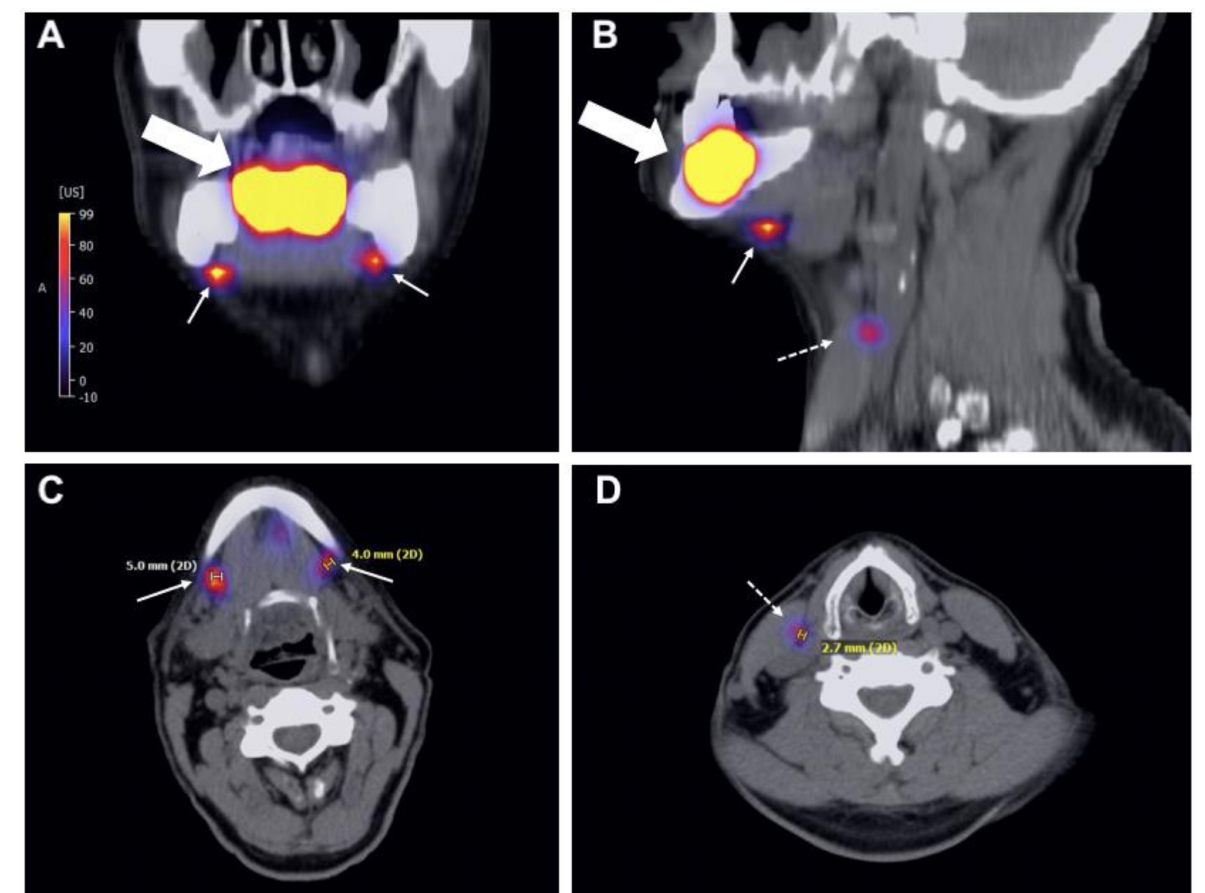
Figure 1. Multiplanar reconstruction of the SPECT/CT of patient no. 9: the two pictures above show the primary tumor of the floor of mouth (thick arrow) and the two foci in level Ib in the coronal ( A ) and sagittal planes ( B ). In the latter picture, a non-sentinel node downstream of the right sentinel node is marked with a thin dotted arrow. The pictures ( C , D ) show the two sentinel lymph nodes and one non-sentinel lymph node in the axial